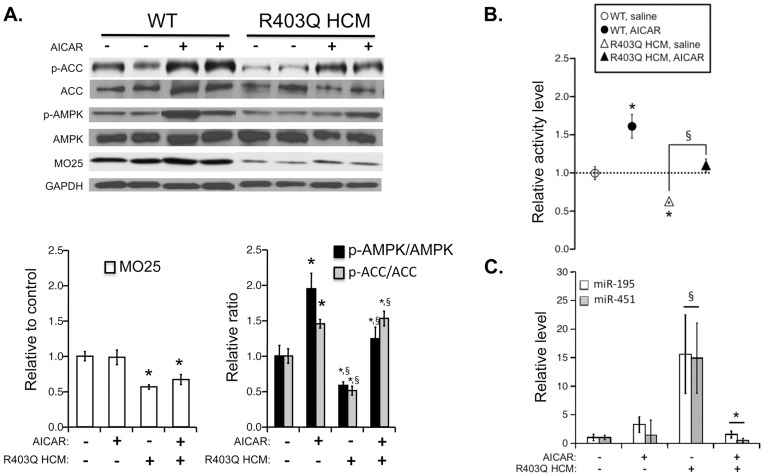
Modification of AMPK signaling axis in R403Q HCM hearts following five-day administration of AICAR.
A: Bar graph summary (top panel) of Western blots (bottom panel) for MO25, AMPK, phosphorylated AMPK (p-AMPK), ACC and p-ACC using left ventricular lysates from 60 day male WT or R403Q HCM hearts with or without AICAR administration. Each bar indicates mean values ± S.E.M. (n = 3 hearts) and represents ratio of total protein to GAPDH or phosphorylated protein to each respective level of total protein following normalization to GAPDH. *P<0.05 compared to controls. B: AMPK activities in WT or R403Q HCM hearts following five-day administration of AICAR. Each plot indicates mean values ± S.E.M. of 5 separate experiments. *P<0.05 compared to respective control group; § P<0.05 compared to WT control group. C: Relative expression of miR-195 and miR-451 in WT or R403Q HCM hearts following AICAR treatment. Expression levels were determined by RT-PCR and illustrated relative to WT saline injected animals. Data are presented as the mean values ± S.E.M. of 4–5 samples. *P<0.05 compared to respective control group; § P<0.05 compared to WT control group.